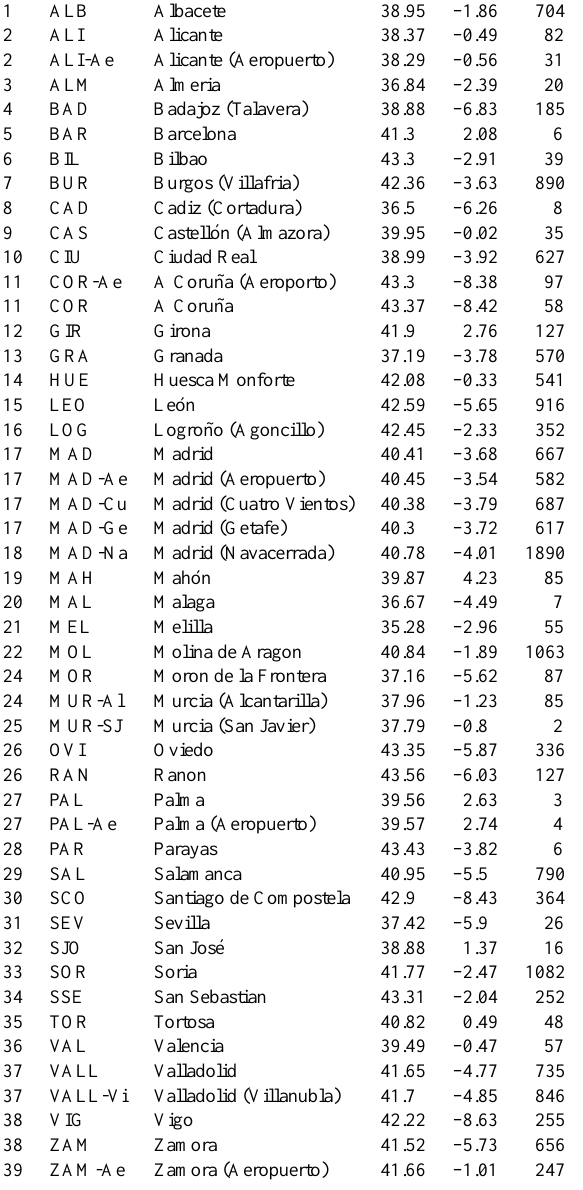
Table 1. List of stations used indicating the code for Fig. 1b, name, longitude, latitude and